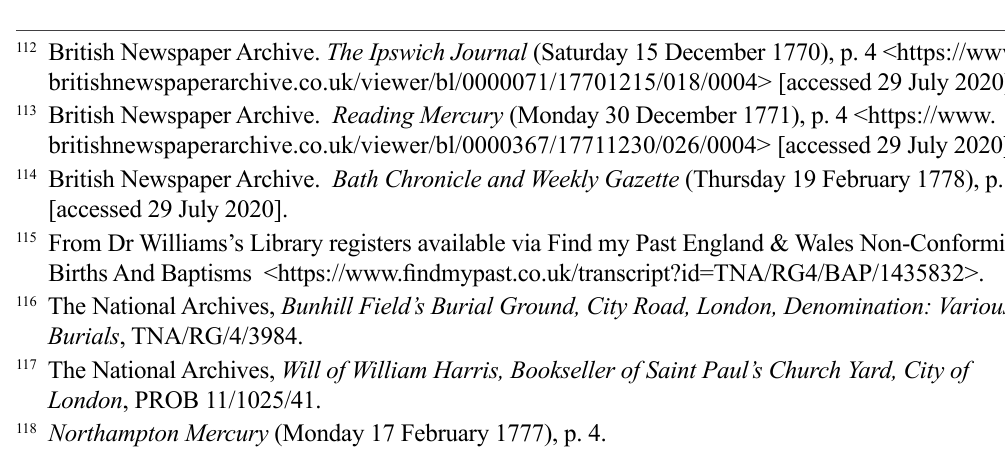
Fig. 34. Photographs of a binding made for the Old Tuscan